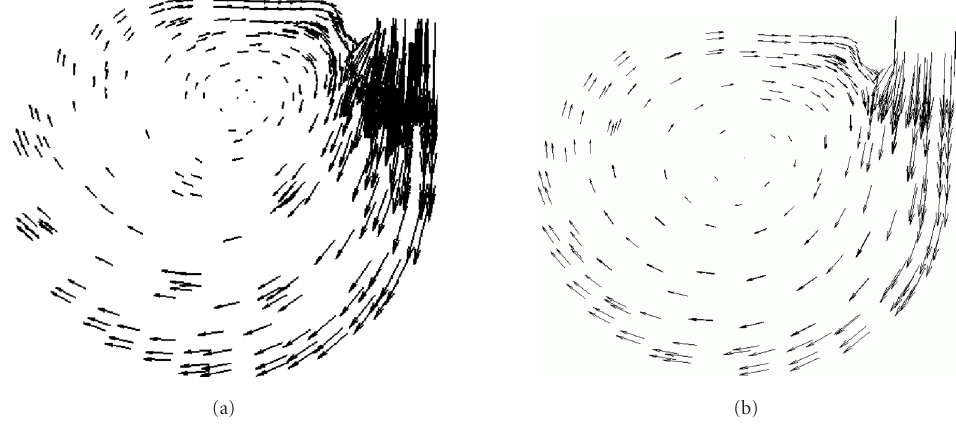
Figure 6: The velocity vectors versus the volute exit ( θ = 180 ◦ ). A single vortex is observed, indicating a well-sized volute. (a) Sharp tongue. (b) Round tongue, showing a shifted vortex center resulting from increased blockage near the tongue.